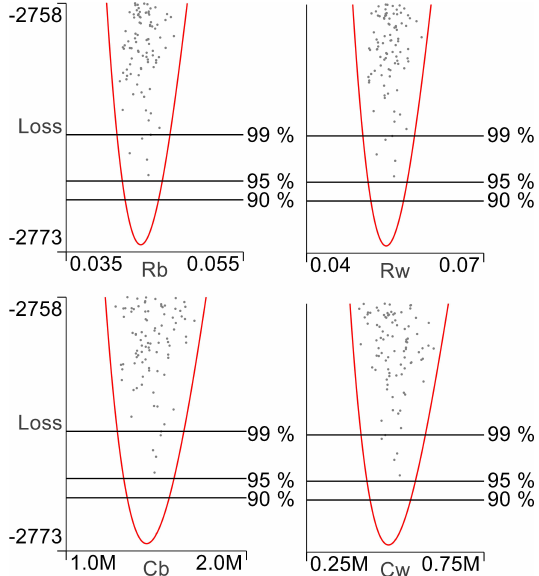
Figure 21: PL1 and URP results for the reduced R2C2 model show that even with K = 500 . 000